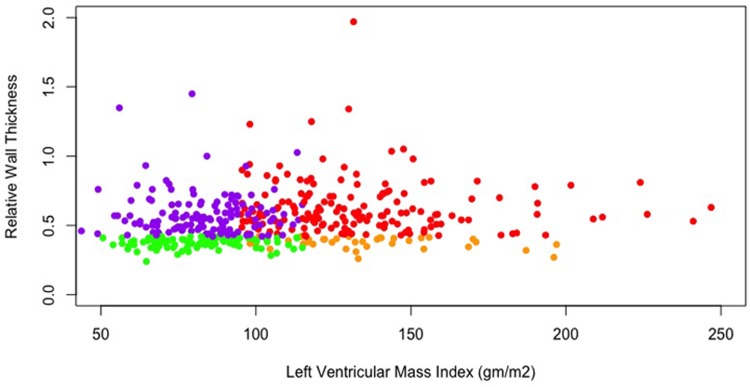
LVMI distributions and left ventricular morphologies.Morphologies of the left ventricle were defined as: normal (normal LVMI with RWT ≤0.42) (green), cardiac remodeling (normal LVMI with RWT >0.42) (purple), concentric LVH (elevated LVMI with RWT >0.42) (red) and eccentric LVH (elevated LVMI with RWT ≤0.42) (orange). LVH: left ventricular hypertrophy (male: >115 g/m2 and female: >95 g/m2), LVMI: left ventricular mass index, RWT: relative wall thickness.